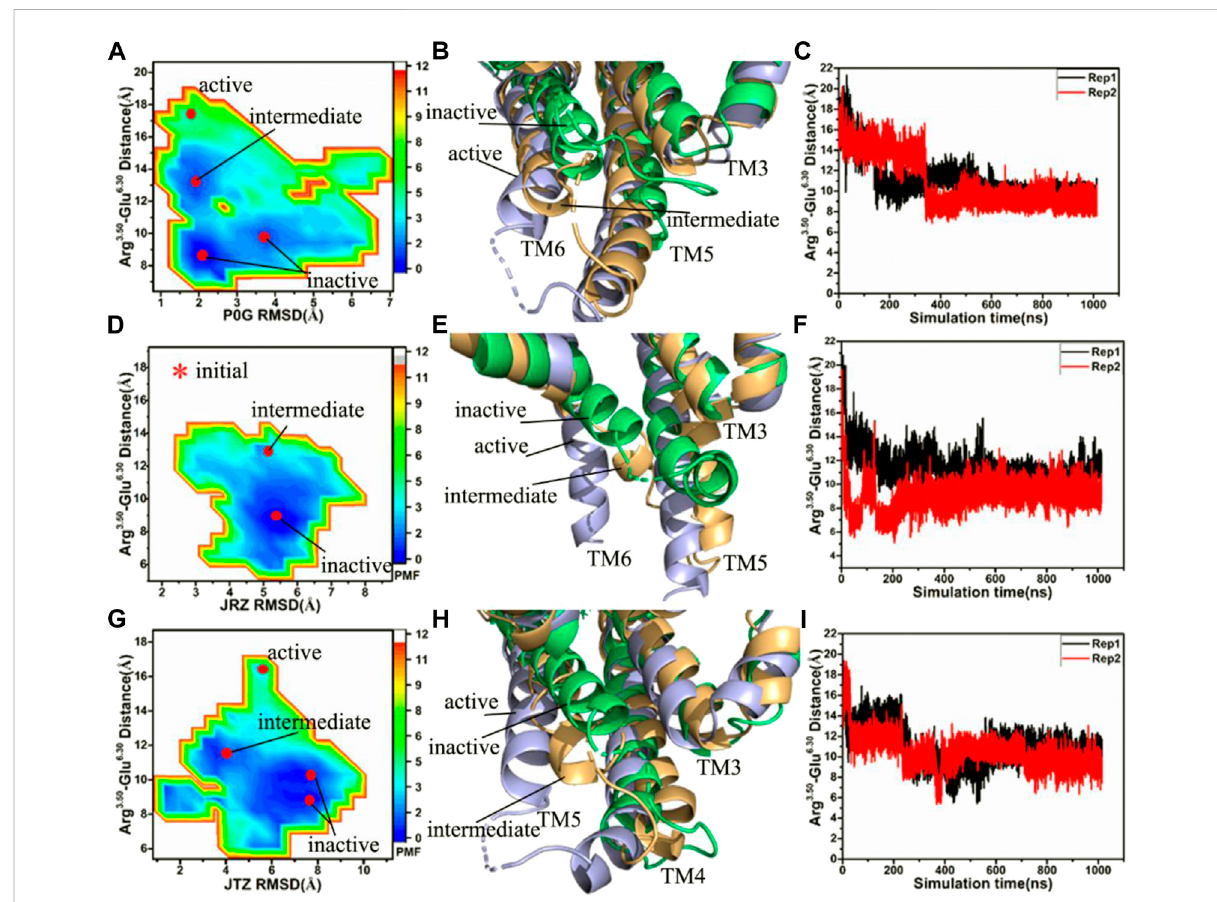
FIGURE 2 Freeenergylandscapesandconformationalchanges: (A,D,G) correspondingtofreeenergylandscapesoftheP0G-,JRZ-,andJTZ-bound β 2 AR without the Gs protein constructed using the distances between the C α atoms of residues Arg 3.50 and Glu 6.30 and the RMSDs of ligands, respectively, (B,E,H) representing structural superimposition of the P0G-, JRZ, and JTZ-bound active, intermediate and inactive β 2 AR without binding of the Gs protein, individually, and (C,F,I) indicating the evolution of the distance between the C α atoms of residues Arg 3.50 and Glu 6.30 as the simulated time in the P0G-, JRZ-, and JTZ-bound β 2 AR without the Gs protein, separately. PMF is scaled in